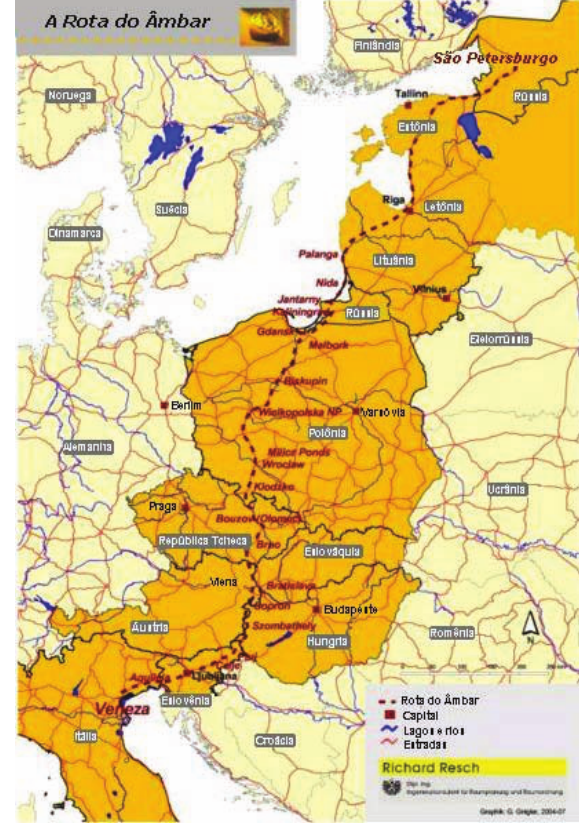
Fig. 2. Fragment of the basic map of Russian Empire in 1812 marked with the number of mail